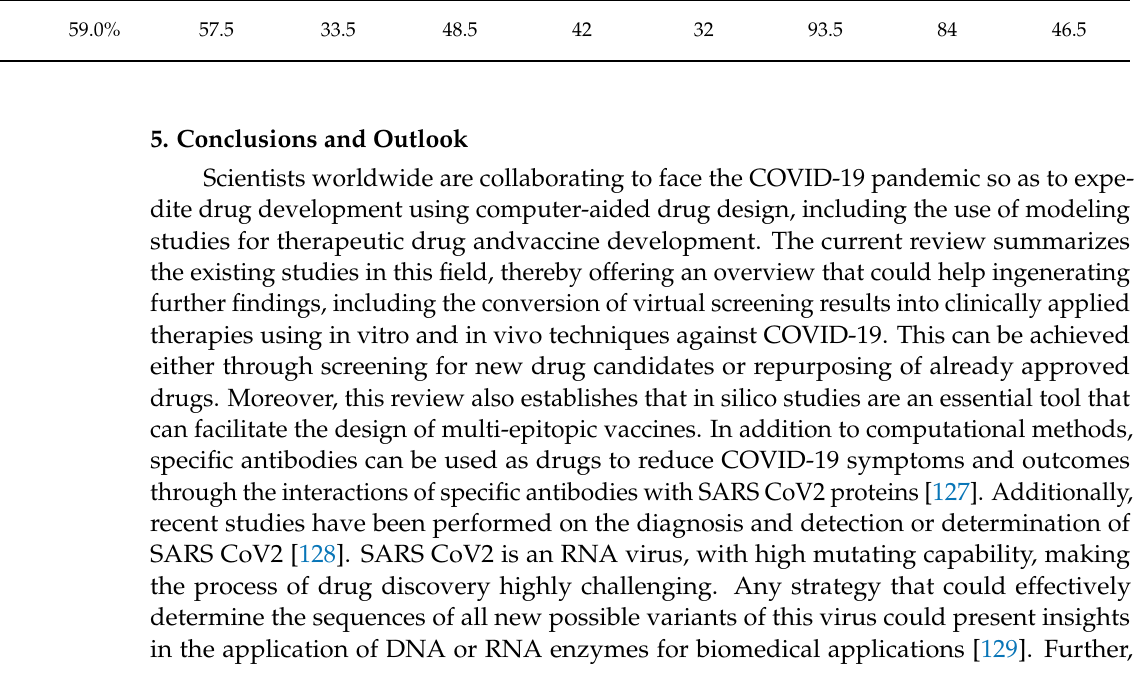
HADDOCK score (kcal/mol) water-refined